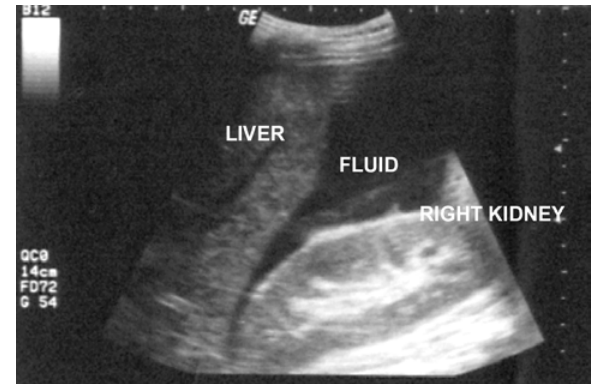
Figure 1 – Sonography showing free intraperitoneal fluid.